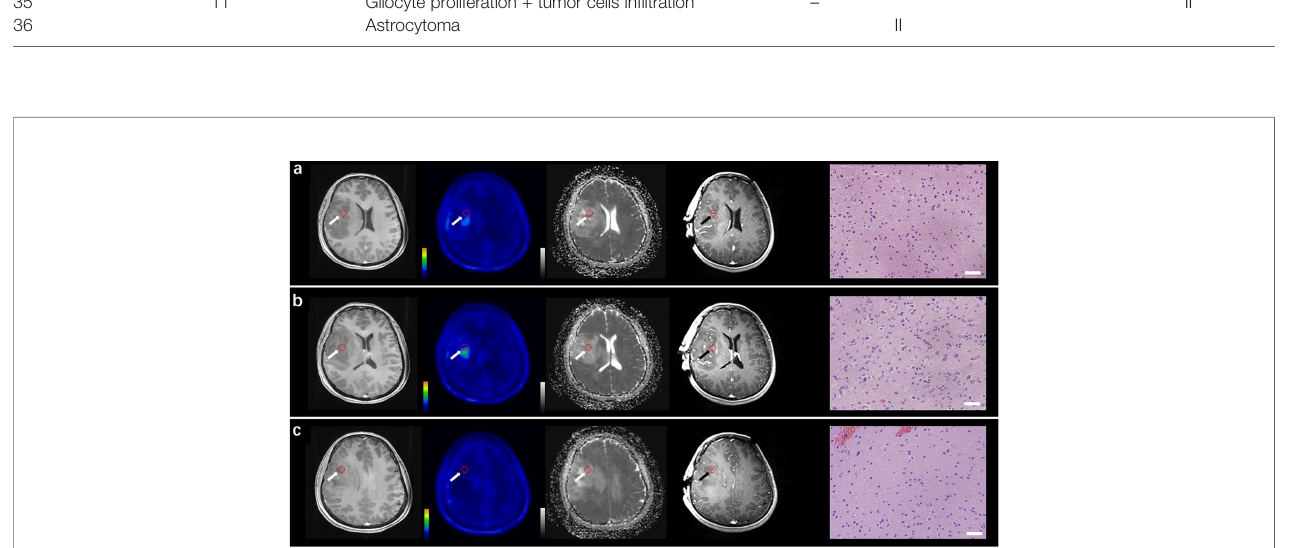
FIGURE 1 | CE MRI, 18F-FET-PET and DWI-ADC map performed before biopsy, CE MRI performed after biopsy, and hematoxylin and eosin (H&E) staining (×40) of the biopsy samples. Samples located in different regions within glioma tissue with different FET-PET uptake and ADC value were taken. H&E staining showed WHO grade and the samples were also tested to analyze gene phenotypes. (A, C) Samples located in the region with increased FET-PET uptake and low ADC value in DWI. H&E staining showed this area contained reactive gliocyte proliferation without obvious atypia nuclear. (B) A sample located in a region with increased FET-PET uptake and high ADC value in DWI. H&E staining showed a cellular glioma corresponding to Oligodendroglioma of WHO grade